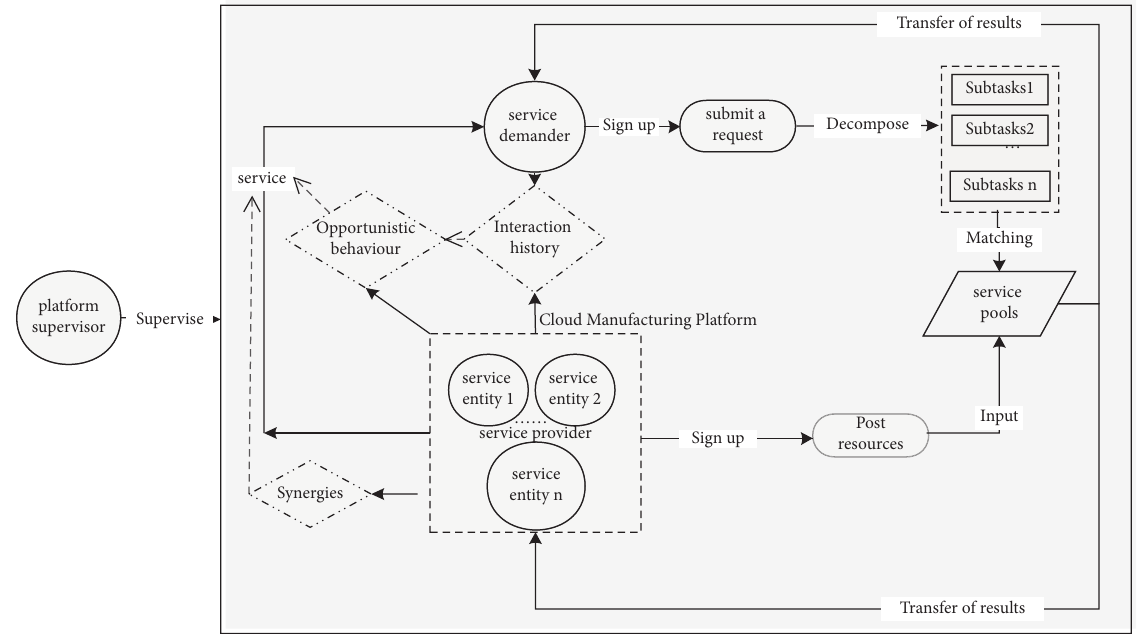
Figure 1: Cloud manufacturing service process